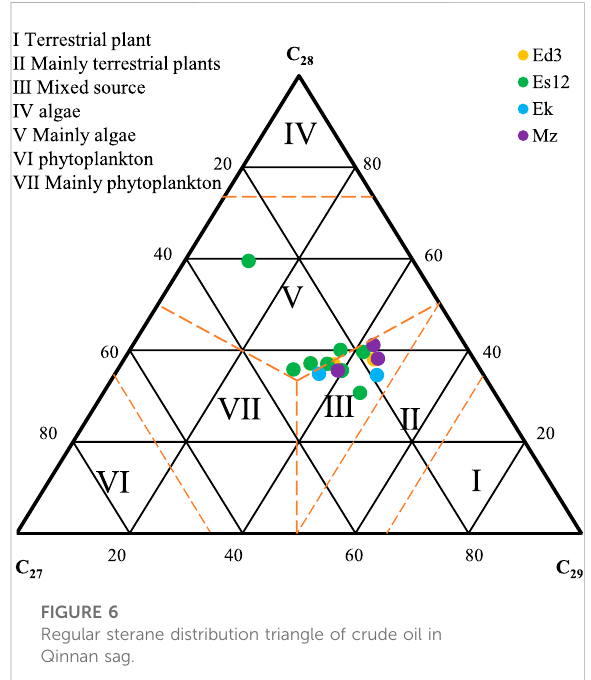
FIGURE 6 Regular sterane distribution triangle of crude oil in Qinnan sag.